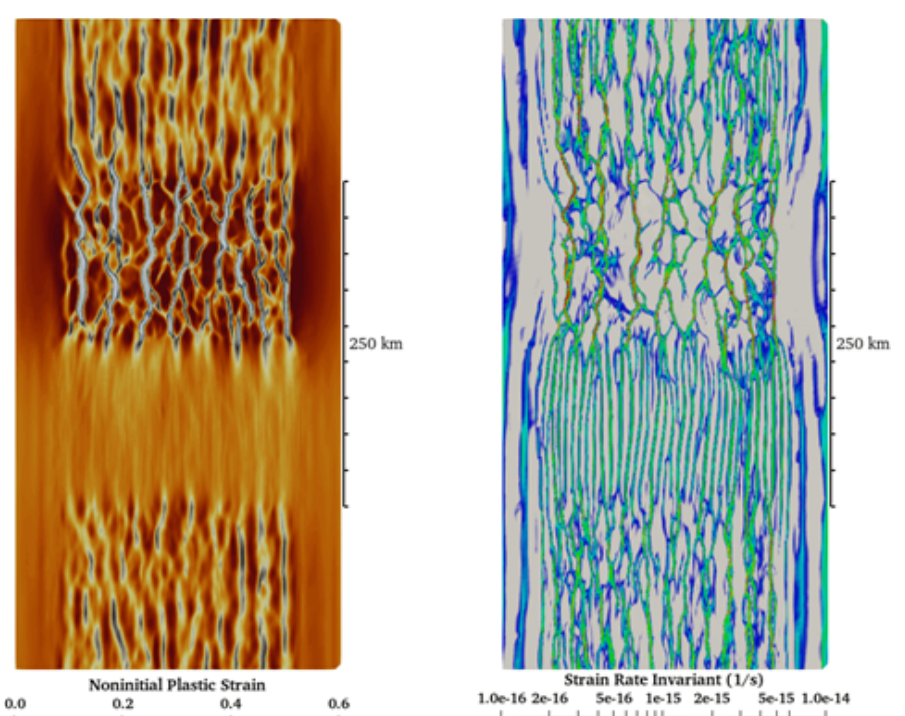
Figure B1. Screenshot taken at 10Myr. The left panel is a model 4 run showing the non-initial plastic strain interval across 10Myr. The right panel is a model 4 run across 10Myr showing the strain-rate-invariant attribute. See Fig. 4a and c for snapshots throughout the model run.